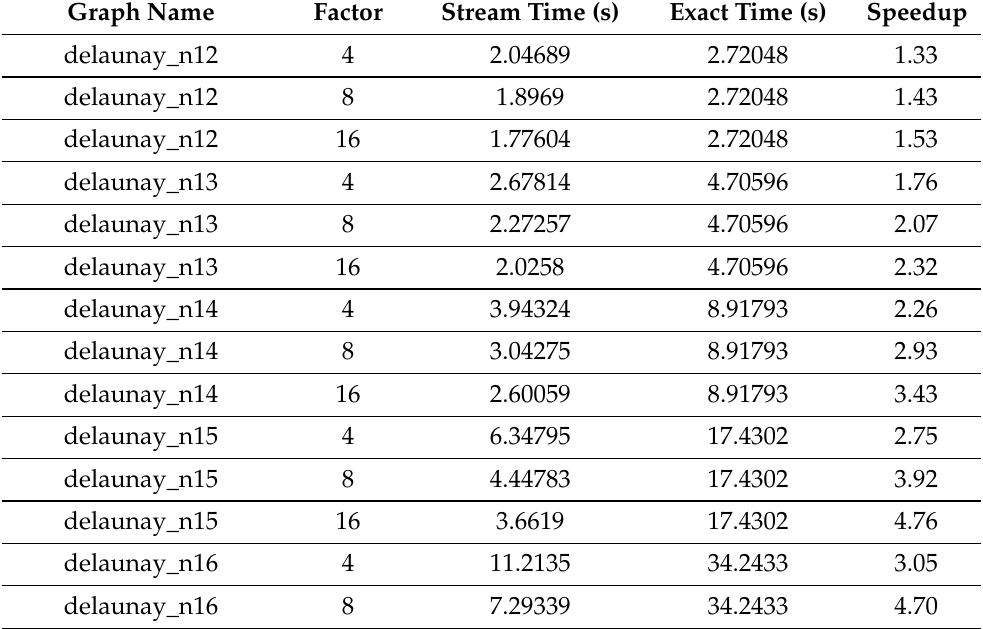
Table 6. Speedup of Stream graph